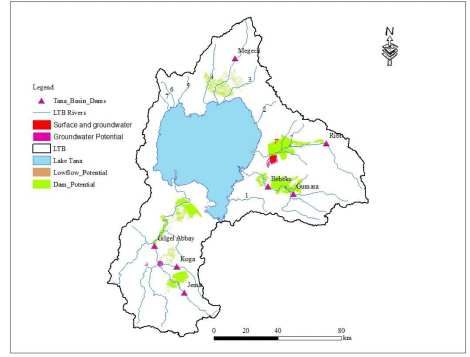
Figure 14. Irrigation potential of surface and groundwater on the irrigable